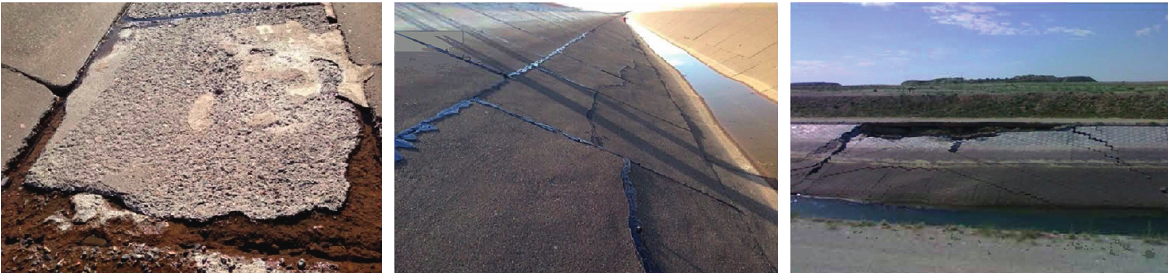
Figure 1: Typical damages of canals in northern China [2,